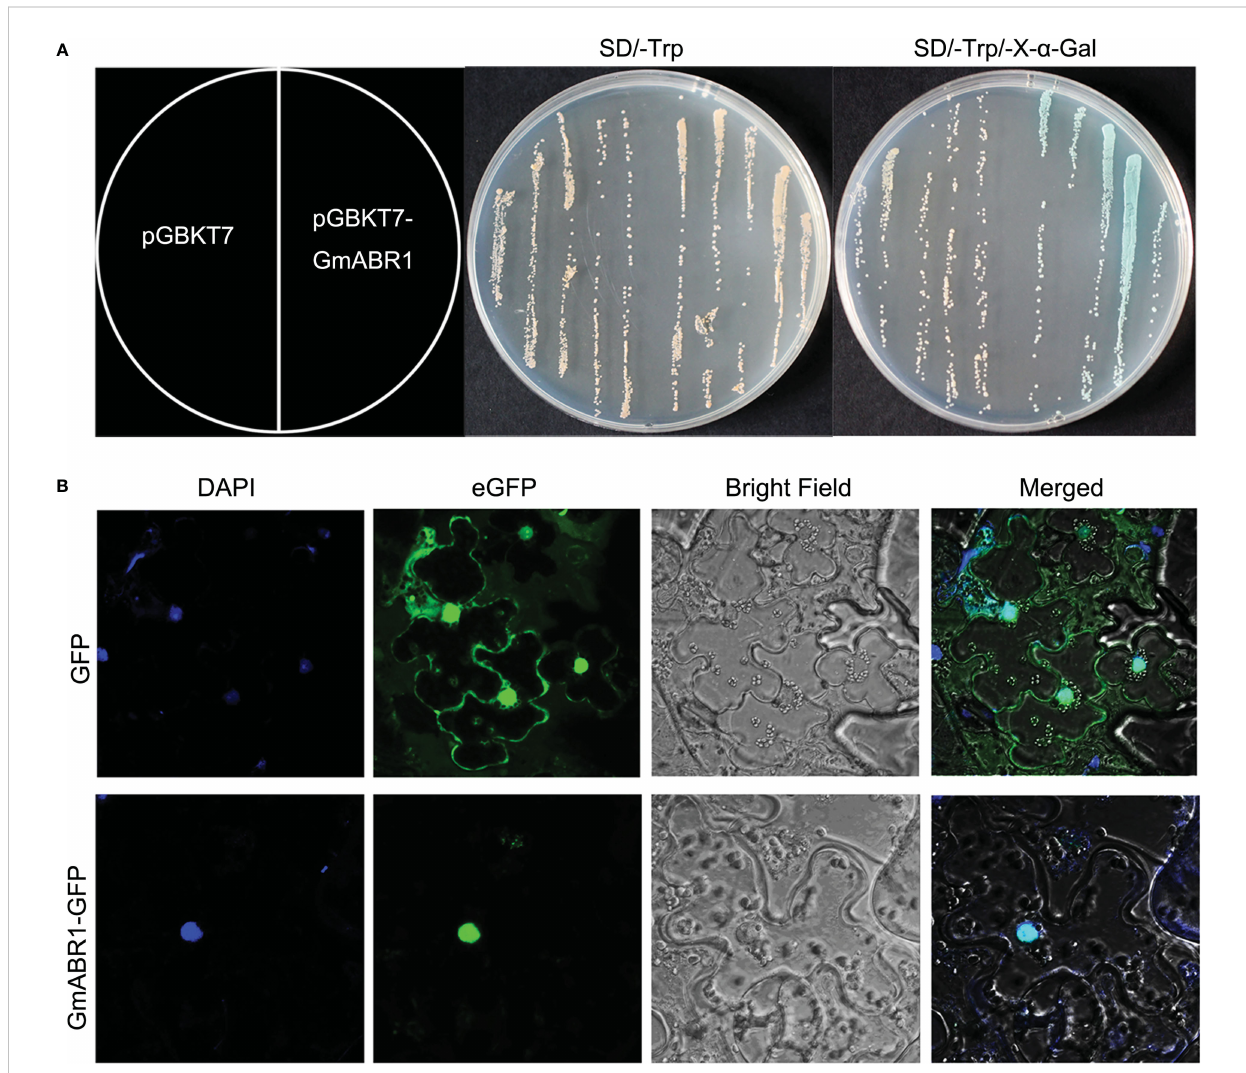
FIGURE 2 Transcriptional activity detection and subcellular localization of GmABR1 protein. (A) Transcriptional activation of GmABR1 protein. (B) Subcellular localization of GmABR1 protein. The CDS of GmABR1 sequence was fused with the GAL4 DNA binding region of pGBKT7 vector and expressed in yeast strain Y 2 H Gold. After the transformation, the two positive clones were transferred to SD/-TRP solid medium, and the other group was added with substrate X-a-Gal. The pCAMBIA1302-GFP-GmABR1 and pCAMBIA1302-GFP vectors were transformed into Agrobacterium tumefaciens GV3101 (contain the virus protein P19) respectively, and then injected into 4-week old Nicotiana tabacum L epidermal cells. After cultured for 2 days later, the leaves were observed by laser confocal microscopy (Carl Zeiss, Jena,